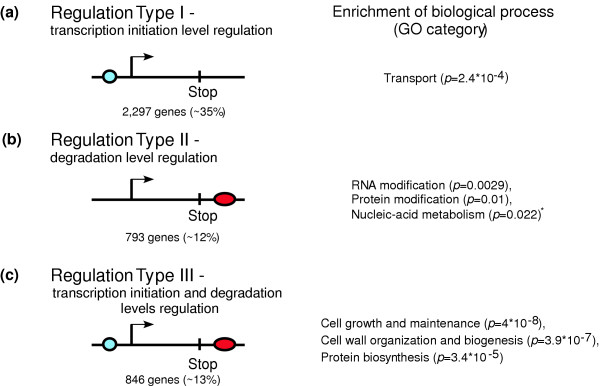
Three types of mRNA transcript regulation. (a) Type I: transcription initiation level regulation - genes that contain promoter regulatory motif(s) (blue circle) in their promoter according to Harbison et al.'s data [25], but do not contain any of the stability-associated motifs from the present analysis. (b) Type II: transcript degradation level regulation - genes that contain stability-associated motif(s) (red oval) from the present analysis but do not contain any of the promoter motifs from [25]. (c) Type III: combined transcription initiation and transcript degradation level regulation - genes that contain both promoter motif(s) and stability-associated motif(s). The figure shows the number of genes in each regulation type and the enriched biological processes that were found for them. Enrichment was calculated as a hypergeometric p-value using GO annotations.The enriched processes that were found significant after FDR (q-value = 0.1) are stated for types I and III. *In type II only borderline significance was found, (no term passed FDR) and those are reported along with their p-values.